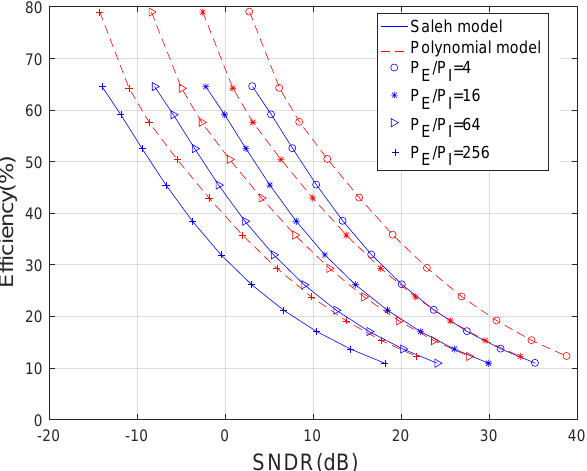
Figure 8. The tradeoff relationship between SNDR and PA efficiency with varying power ratios (Class B PA, Case I(1), Saleh, and polynomial models.